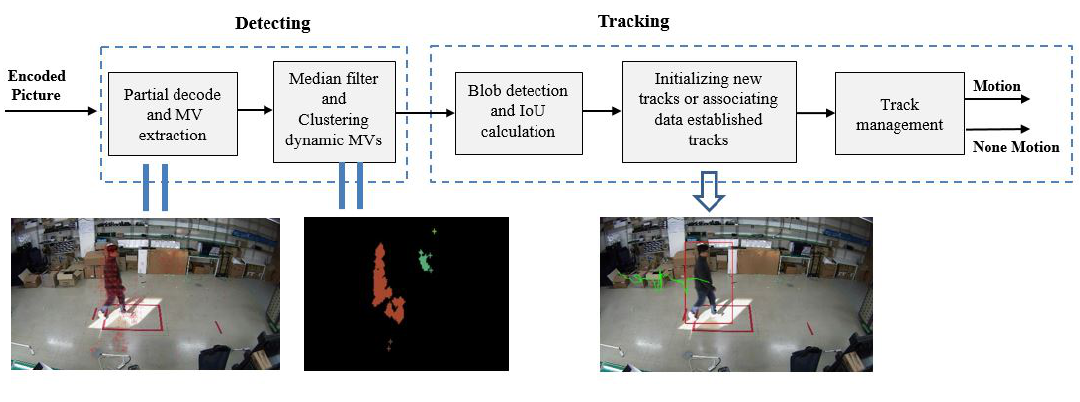
Figure 6. Workflow of the proposed detection-based tracking approach in the compressed-domain. MV, motion